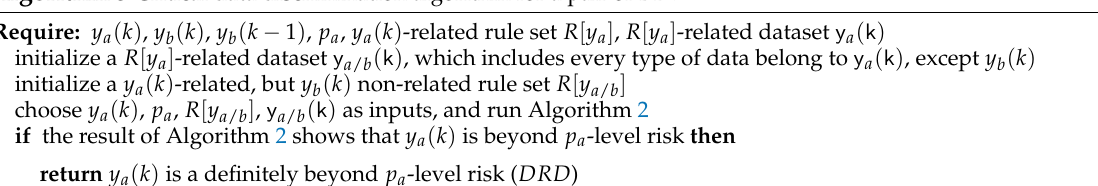
Algorithm 3. Here, we assume that y b ( k ) ∈ y a − p Algorithm 3 Critical data discrimination algorithm for a pair of BD